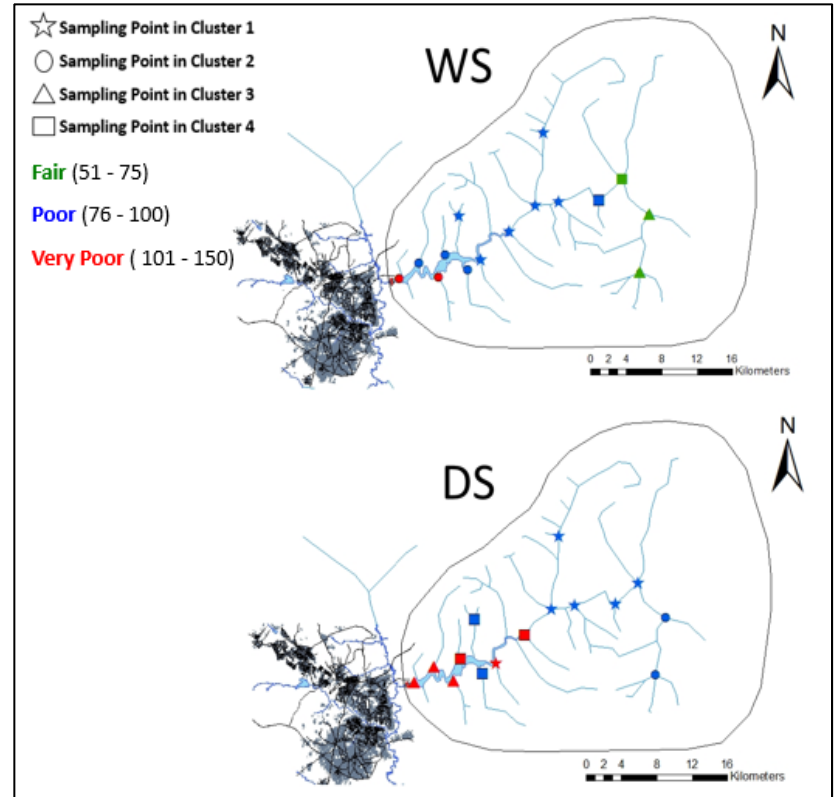
Fig 4: Cluster of Galma River monitoring sample points Fig. 4: Cluster of Galma River monitoring sample